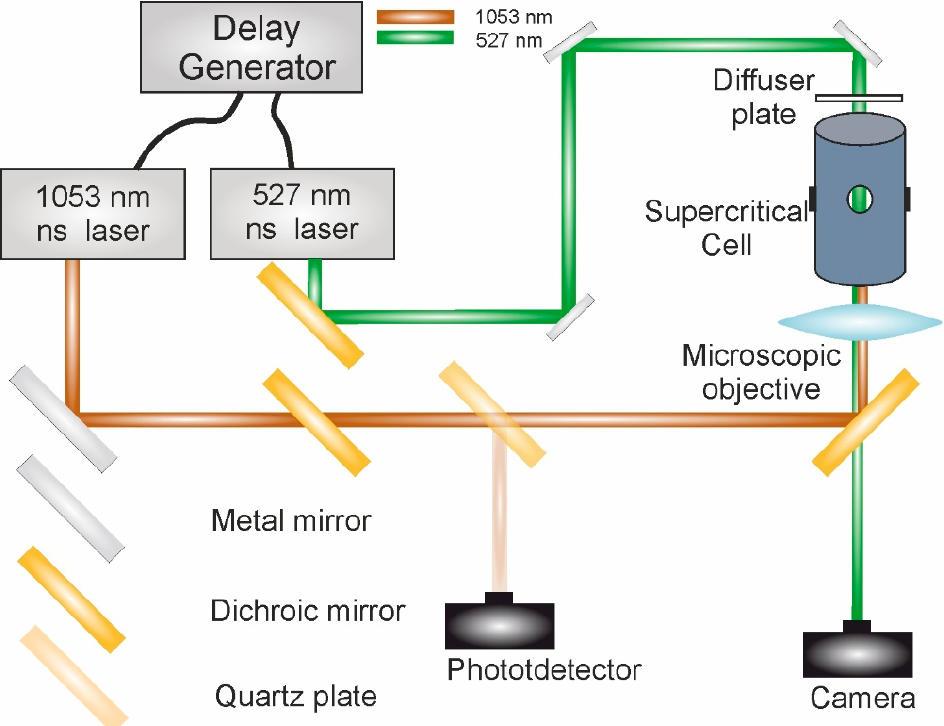
Figure 1. Experimental setup. The energy of the pump pulse is 400 μ J, the wavelength is 1053 nm, the time duration is 6 ns, and the repetition frequency is 10 Hz. The pump pulse focused into the supercritical cell. The pressure and temperature in the cell are varied from 1 bar up to 160 bar (measurement error ~0.1 bar) and from 20 °C up to 60 °C (measurement error ~0.1 °C). In CO 2 (99.99% purity) shock waves and cavitation bubbles were generated. The probe pulse is scattered on the diffusion plate and collected by the lens on the CCD